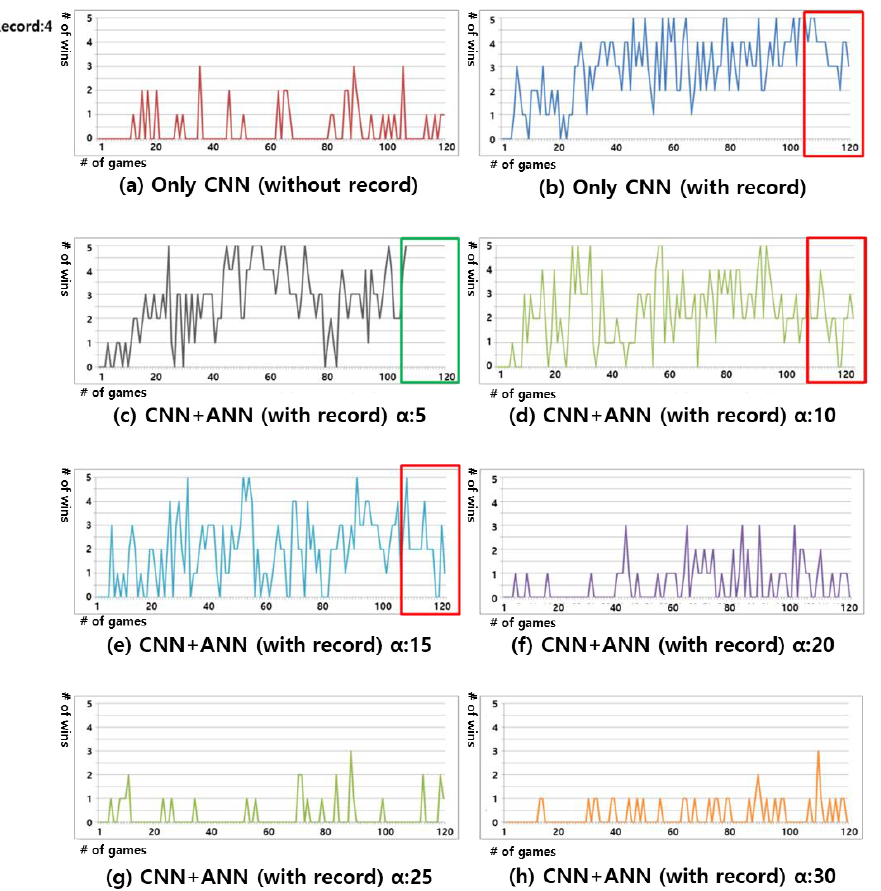
Figure 6. Result of win rate when record count was four. Each graph y -axis refers to the number of wins from 0 to 5, and the x -axis refers to the number of games from 0 to 120. The figures show the experimental result using: ( a ) Only CNN without Record relearning; ( b ) CNN with Record relearning without ANN; ( c ) Proposed Gomoku system with ANN α :5; ( d ) Proposed Gomoku system with ANN α :10; ( e ) Proposed Gomoku system with ANN α :15; ( f ) Proposed Gomoku system with ANN α